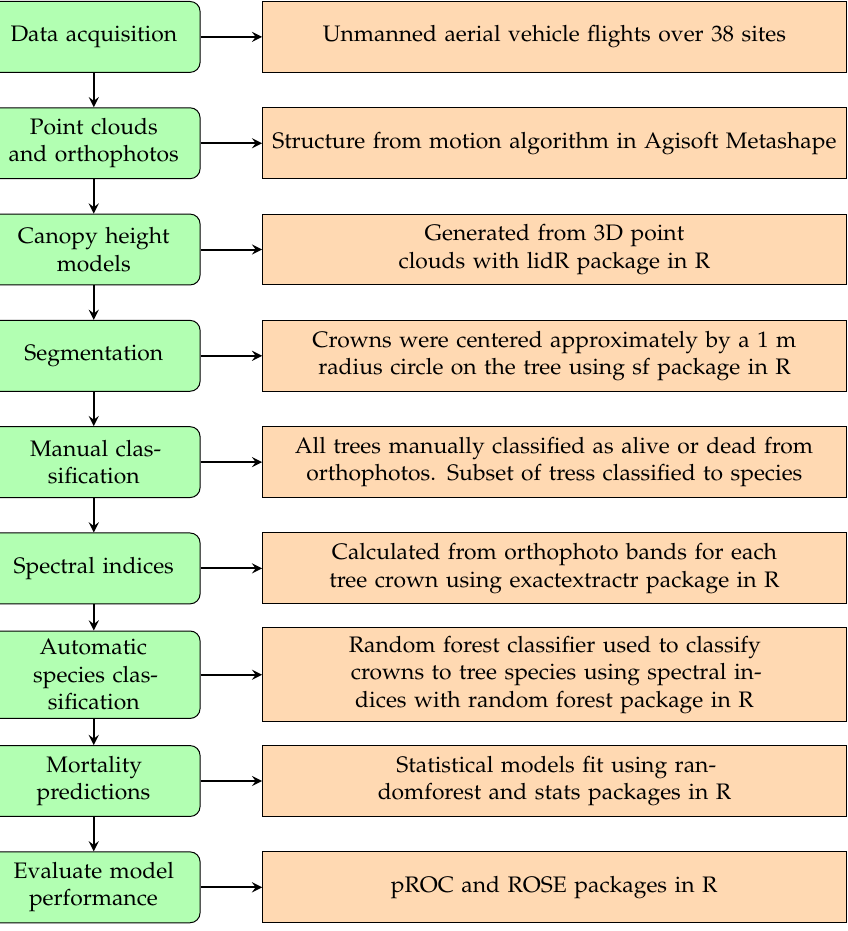
Figure 2. Workflow for processing remotely sensed crown